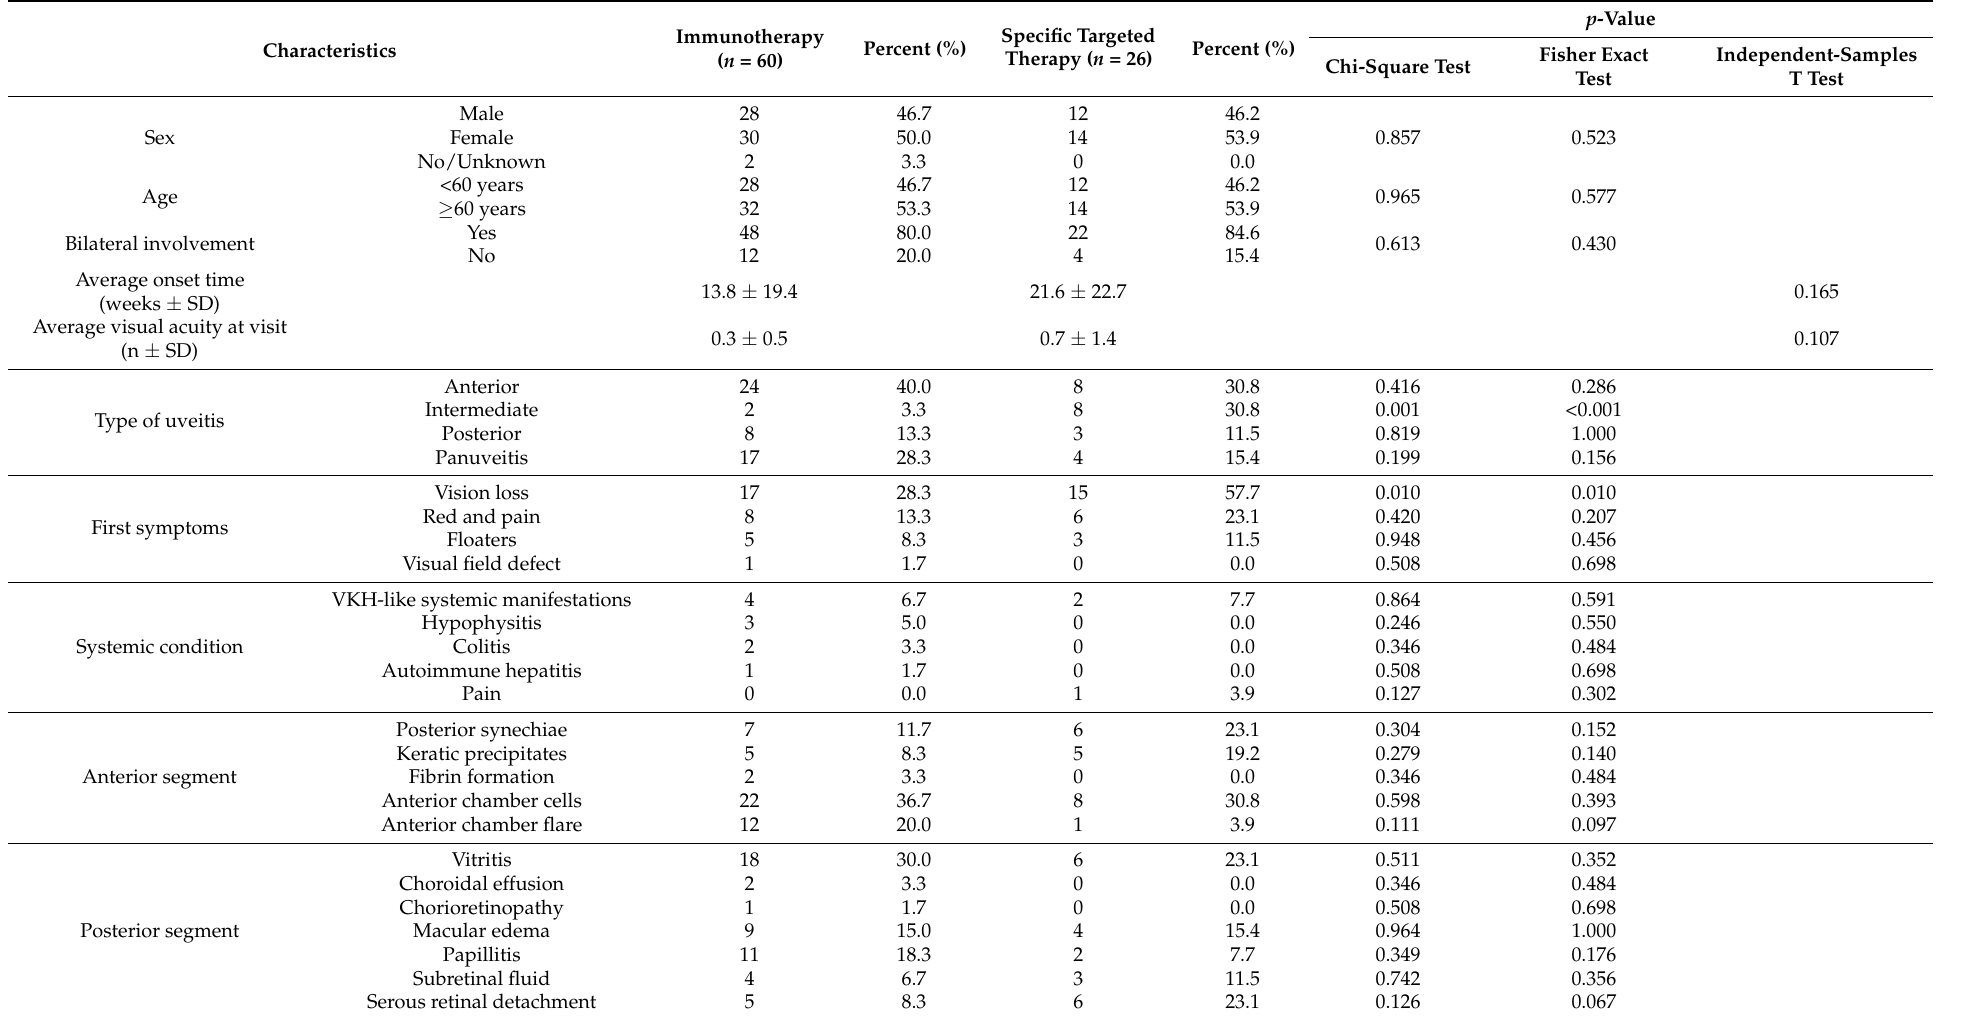
Table 4. Comparison of clinical features of uveitis induced by immunotherapy and specific targeted